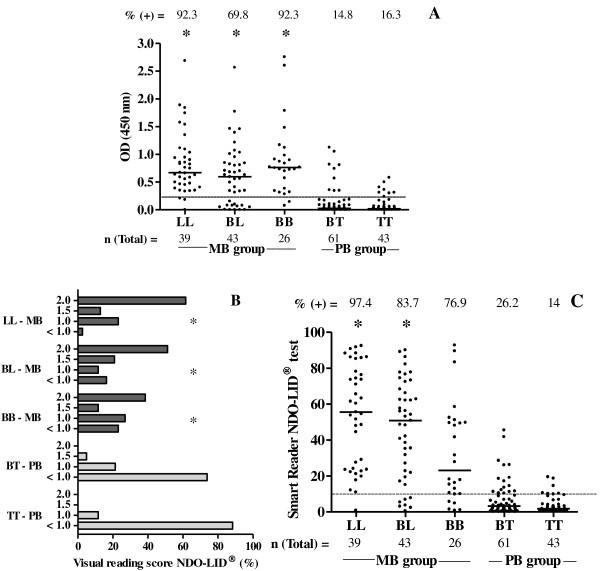
PGL-I ELISA and NDO-LID® tests assessed among multibacillary (MB) and paucibacillary (PB) leprosy groups. The number above each data set is the percentage of positive results and the number below each data set represents the total number of participants of each group. A.: IgM PGL-I ELISA test: each point represents the mean value of optical density (OD) of individual serum samples. The median OD value of each group is represented by the horizontal line. The traced horizontal line is the cut-off (OD ≥ 0.250). * = p < 0.05 (LL versus BT and TT; BL versus BT and TT; BB versus BT and TT). B.: Visual reading of NDO-LID® test scored * = p < 0.05. C.: NDO-LID® test assessed by Smart Reader® platform: each point represents the Smart Reader® result of an individual serum sample. The horizontal line represents the median of the Smart Reader® reading for each group and the traced horizontal line is the cut-off (≥ 10). * = p < 0.05 (LL versus BT and TT; BL versus BT and TT; BB versus BT and TT).